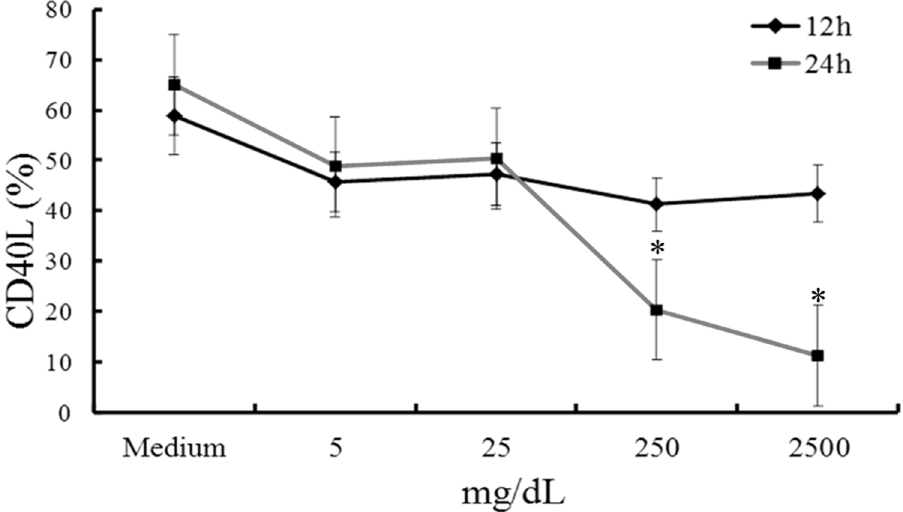
Fig 5. IVIG inhibition of CD40L expression on CD4+ T cells. Greater concentrations (250 mg/dL and 2500 mg/dL) of IVIG significantly inhibited CD40L expression on CD4+ T cells after 24 hours of treatment. * p < 0.05 compared to the average. Data are presented as mean ± standard error. All tests were separately carried out three times each (N =